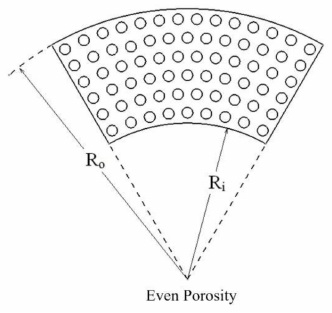
Figure 2. Even distribution of porosity in an